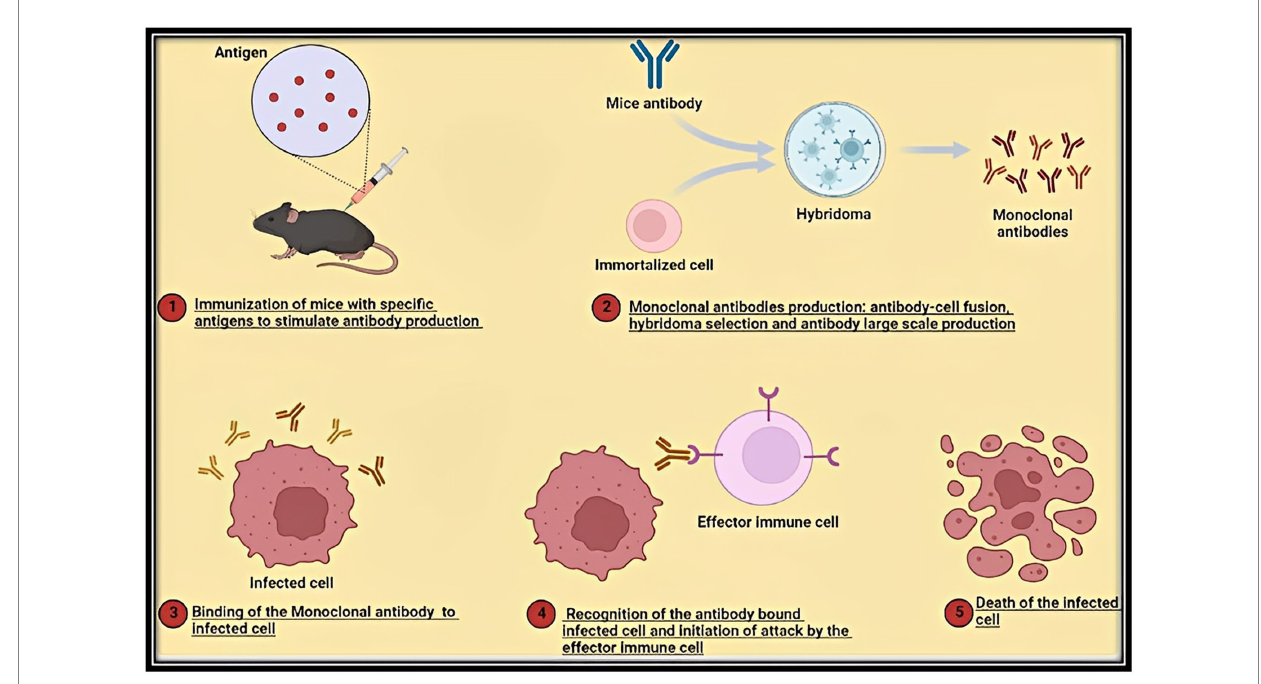
FIGURE 4 Stage wise diagrammatic illustration of the production of monoclonal antibodies via the popular Hybridoma Technology for usage in the case of a broad spectrum of human infectious microbial diseases (Bacterial and